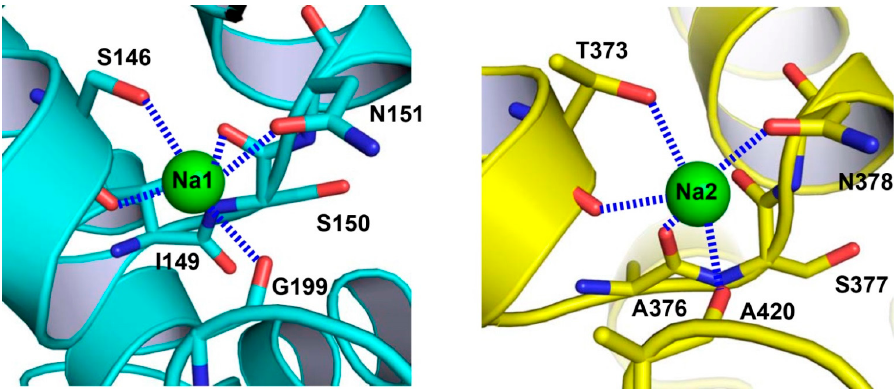
Figure 4. Close-up views of the Na + -binding sites in VcINDY. Structure of the Na + -binding site in the N domain ( left panel ). The previously unobserved Na + -binding site within the C domain ( right panel ). Na + ions are drawn as green spheres and relevant amino acids as stick models. Dashed lines (blue) indicate the coordination interactions.